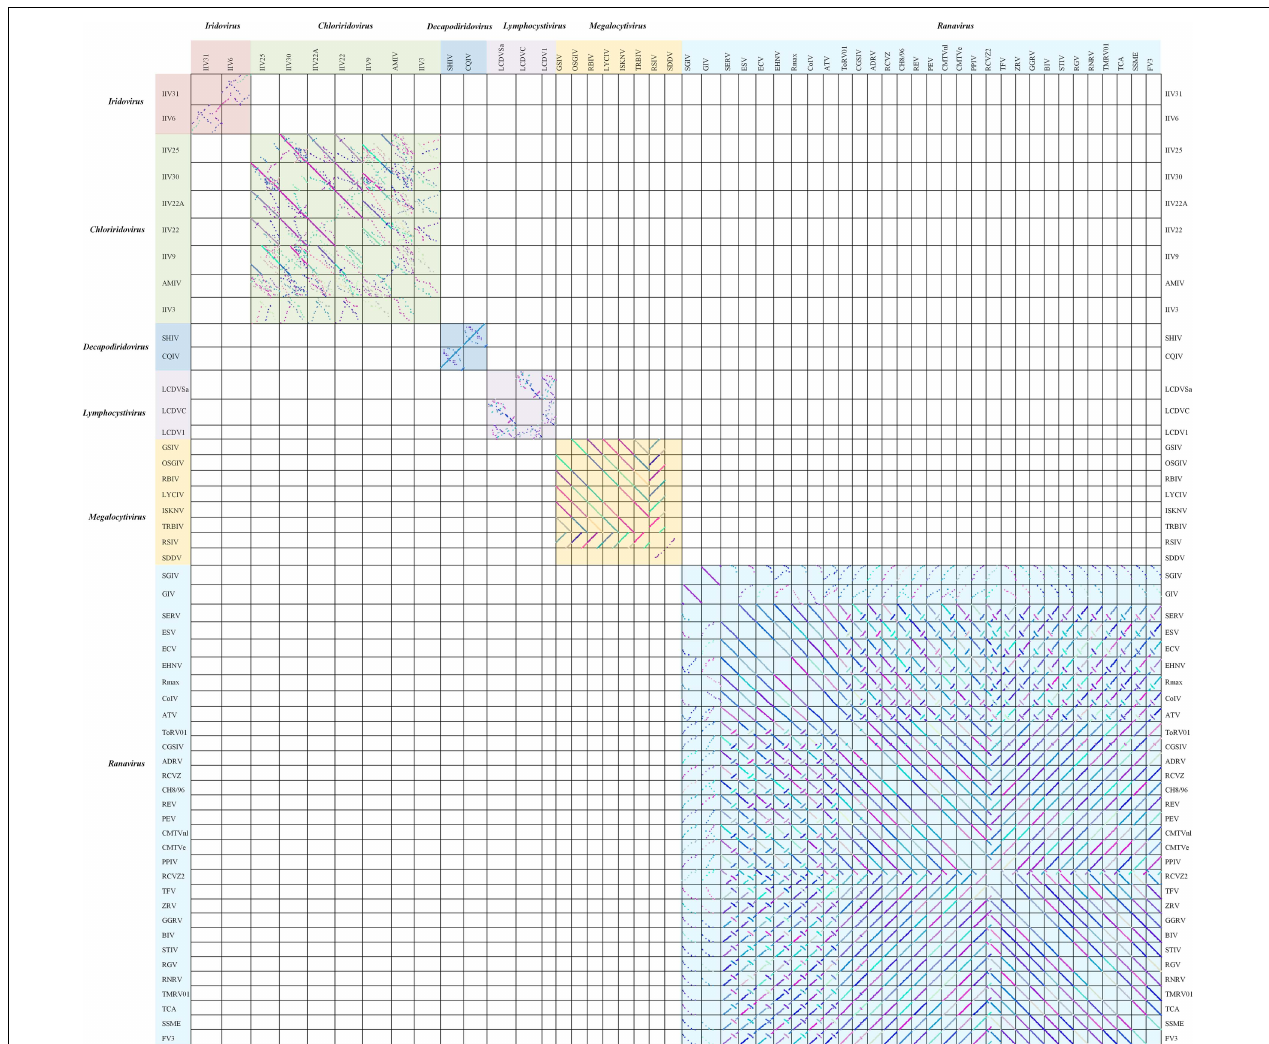
FIGURE 2 | The dot-plotter analysis of 53 members of the Iridoviridae family (identity >